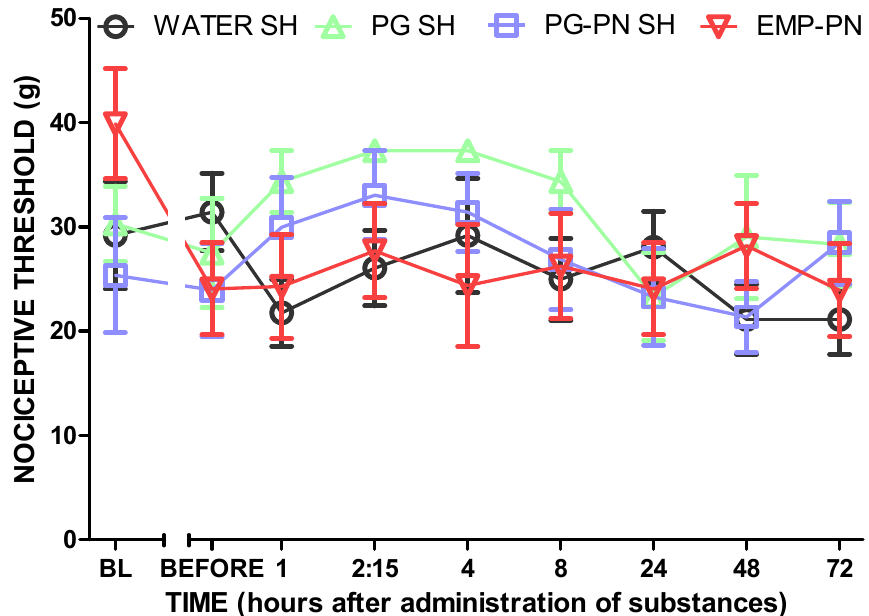
Figure 12. Antinociceptive effect of the comparison between the substances—sham animals—during 72 h after administration. Legend: Pregabalin: PG (10 mg/kg, Orally); WATER: vehicle of PG; PN: polymeric nanocomposite; PG-PN: PG-loaded polymeric nanocomposite (10 mg PG/kg, Orally);